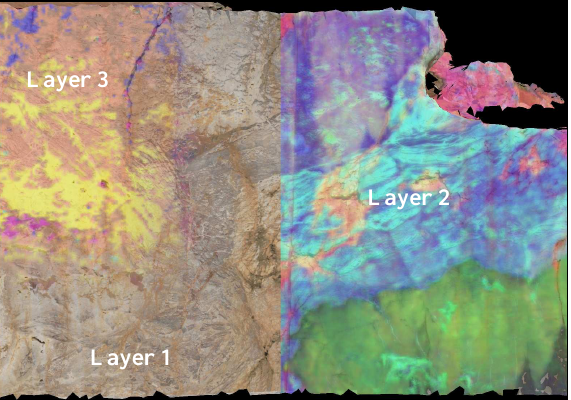
Figure 5. Photorealistic model combining conventional digital imagery and multiple hyperspectral processing layers. Layer 1 is the Nikon imagery (0% transparency). Layer 2 is an MNF image (Fig. 2c), with 50% transparency, 50% horizontal cutoff and a sharp edge transition. Layer 3 is a classification (Fig. 2d), with 40% transparency, a horizontal and vertical cutoff, and a soft edge transition. Height of model c. 20